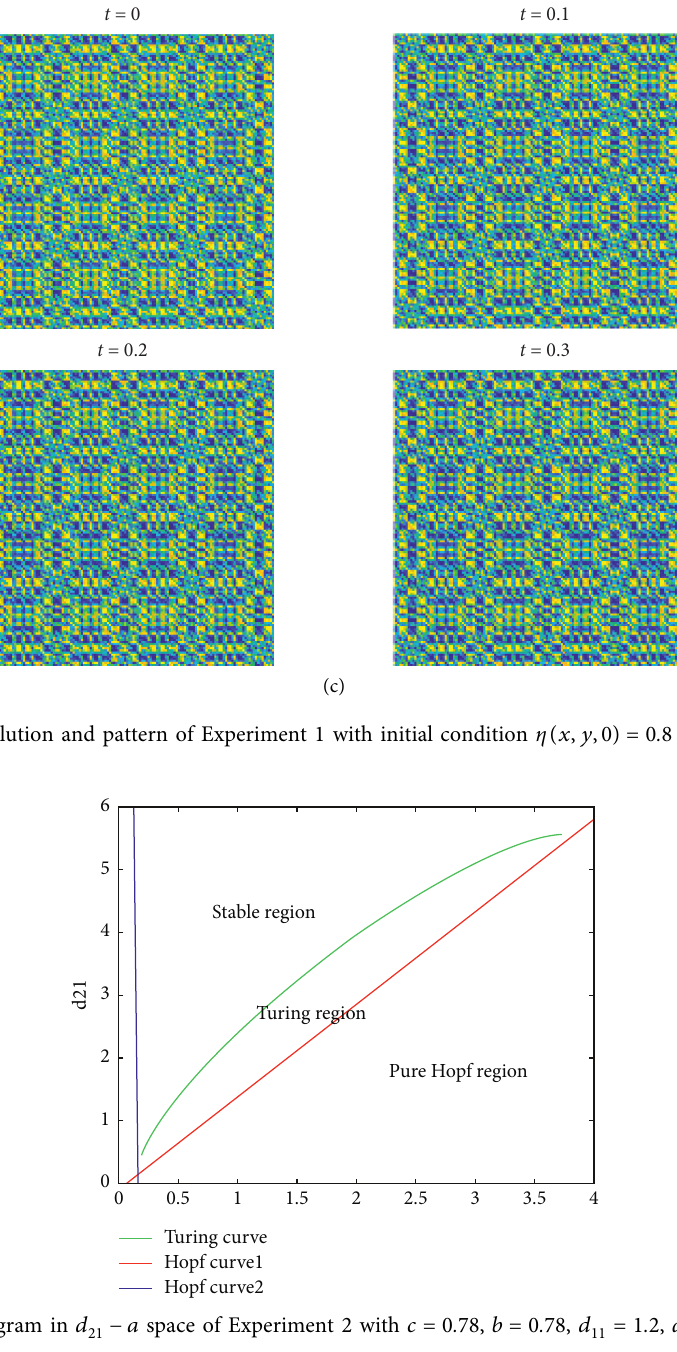
� 1 . 2 , d � 0 . 2 , and d � 0 . 9 ⊳ 11 12 22